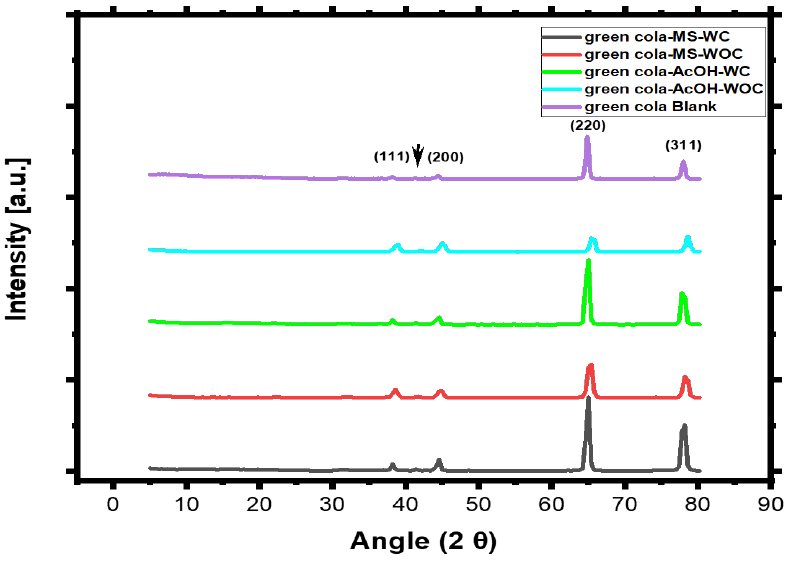
Figure 14. XRD patterns of Green Cola samples after corrosion tests with (WC) and without (WOC) an organic coating studied in the main solution of the soft drink and in acetic acid.